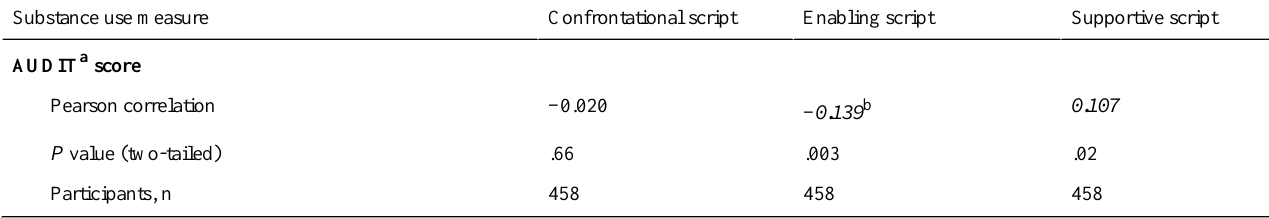
Table 6. Alcohol Use Disorder Identification Test score and script rating